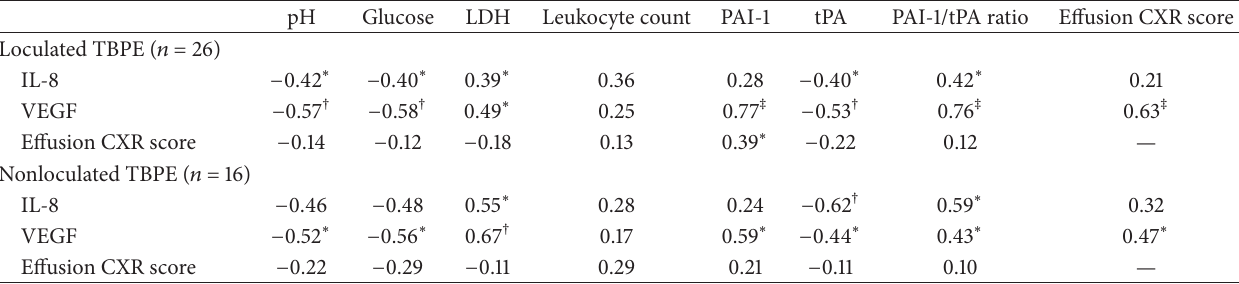
Table 3: Correlation among angiogenic cytokines, fibrinolytic parameters, pleural fluid characteristics, and effusion CXR scores.